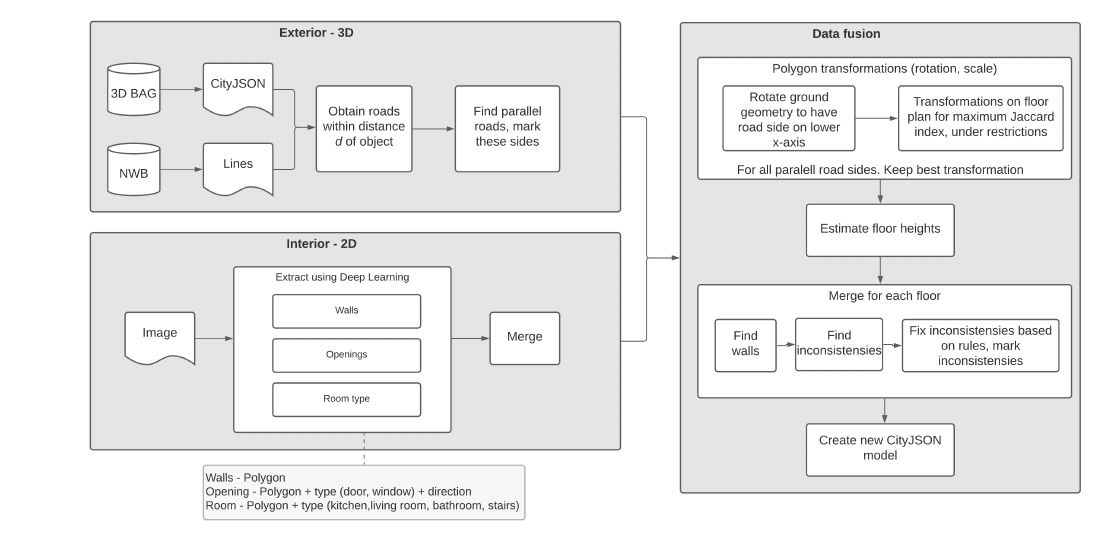
Table 1. Deep learning methods comparison